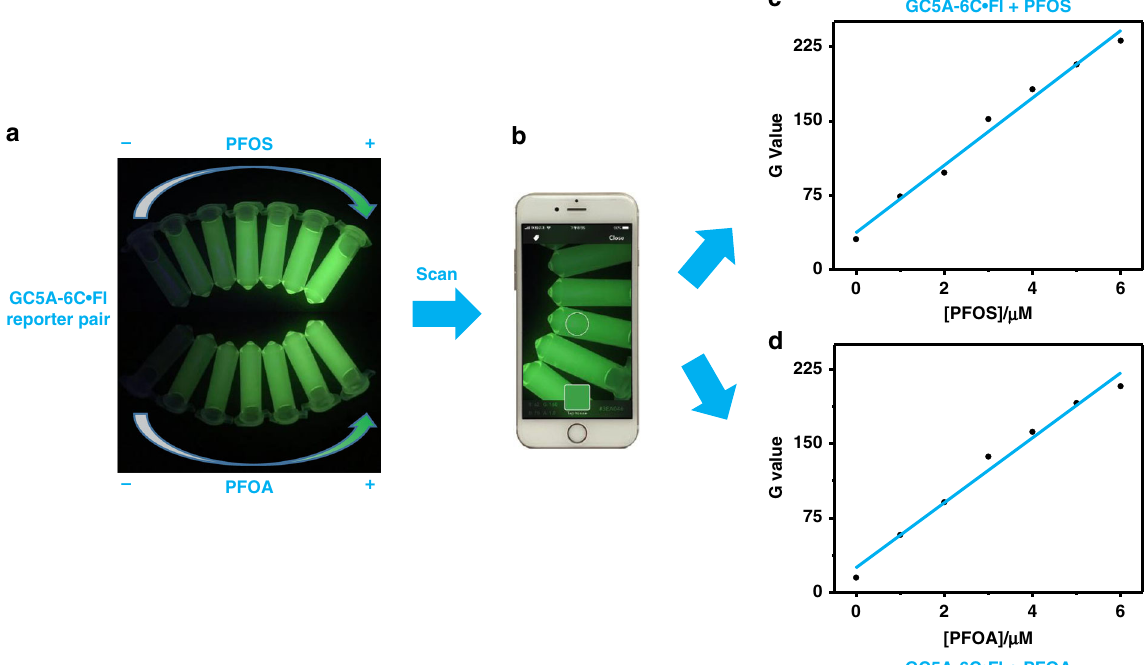
Fig. 6 Real-time/on-site scanometric monitoring of PFOS and PFOA. a The images of the GC5A-6C (cid:129) Fl reporter pair (8.0/10.0 μ M) with various concentrations of PFOS and PFOA (up to 6.0 μ M) taken by an iPhone 7. b The images recorded by iPhone 7 with a color-scanning app. Plots of G values against PFOS ( c ) and PFOA ( d ) concentrations in HEPES buffer at 25 °C. G values are green color intensities directly scanned from the color scanning app.